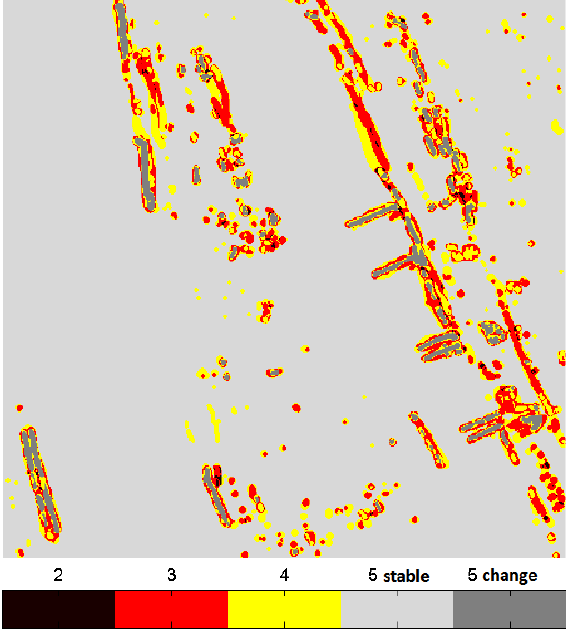
Figure 17. Accordance amongst the five human interpreters for the change in amplitude.